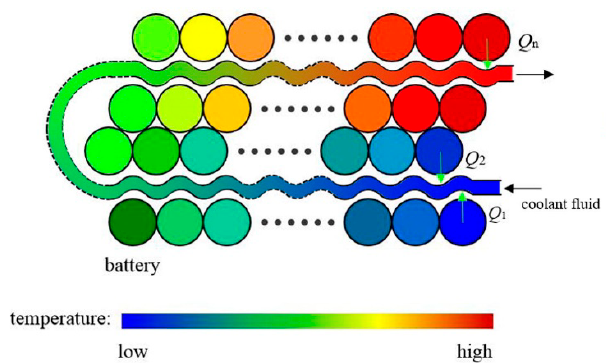
Figure 20. The procedure of a representative liquid cooling method. Adopted from Ref. [246].